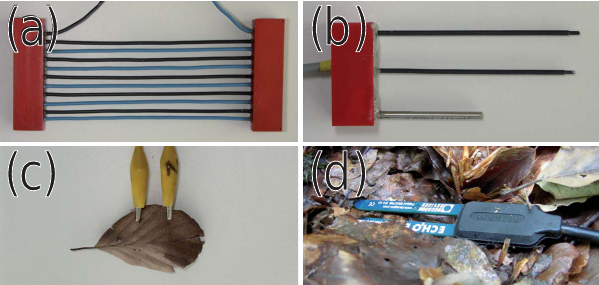
Figure 3. Photographs of the sensors used: (a) flat volume per- mittivity sensor (group a), (b) non-commercial two-rod permittiv- ity sensor (group b), (c) electrical resistance sensor (group c) and (d) commercial ECH 2 O two-rod permittivity sensor (group